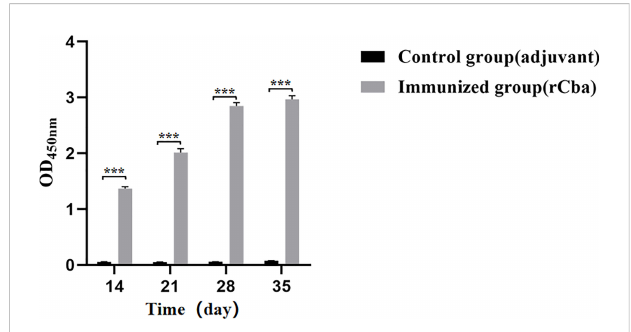
FIGURE 5 Strong immune response induced by rCba in ICR mice. Serum collected on days 7 d, 14 d, 21 d and 28 d after the fi rst immunization. The antiserum was diluted 100 times with PBST, the goat anti-mouse